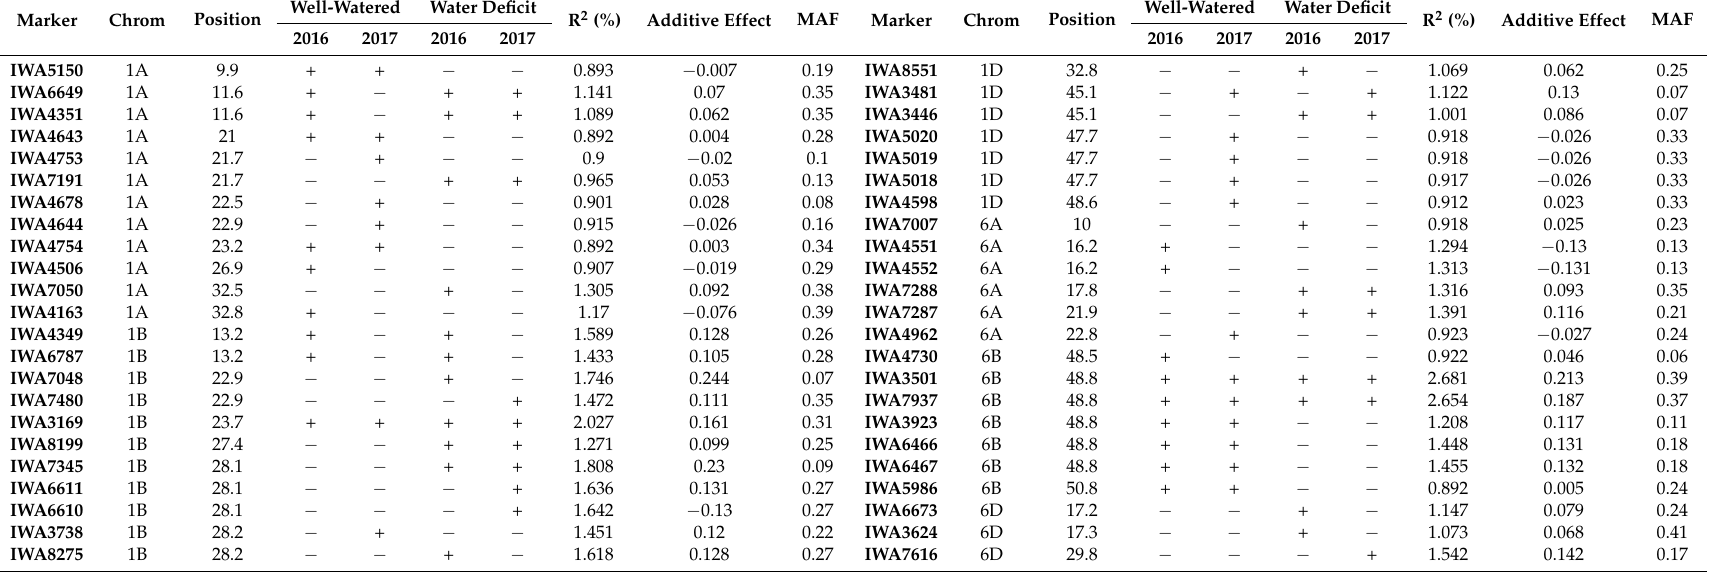
Table 3. SNP markers that found to be significantly linked with GPC under well-watered (control) and water deficit